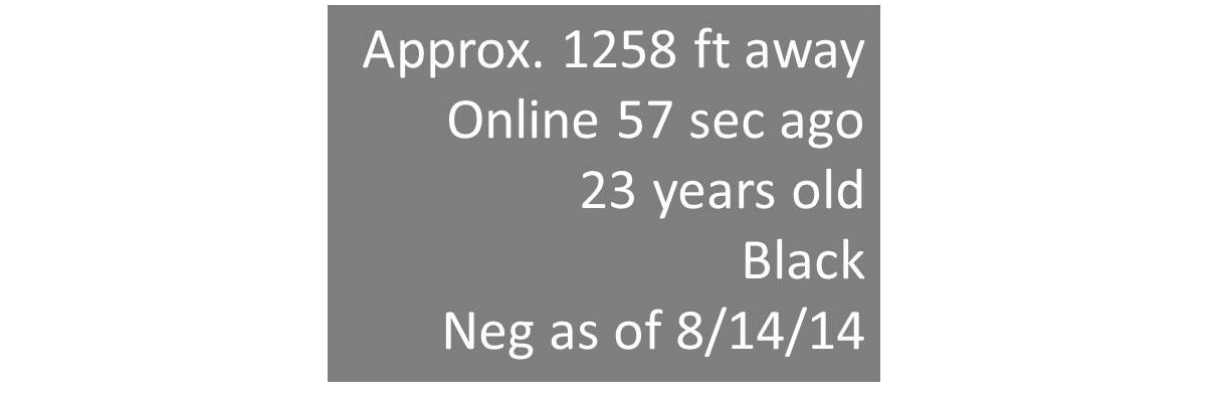
Figure 1. Hypothetical example of social networking application profile data provided by application users (we used age, race, and distance in feet from our location in this